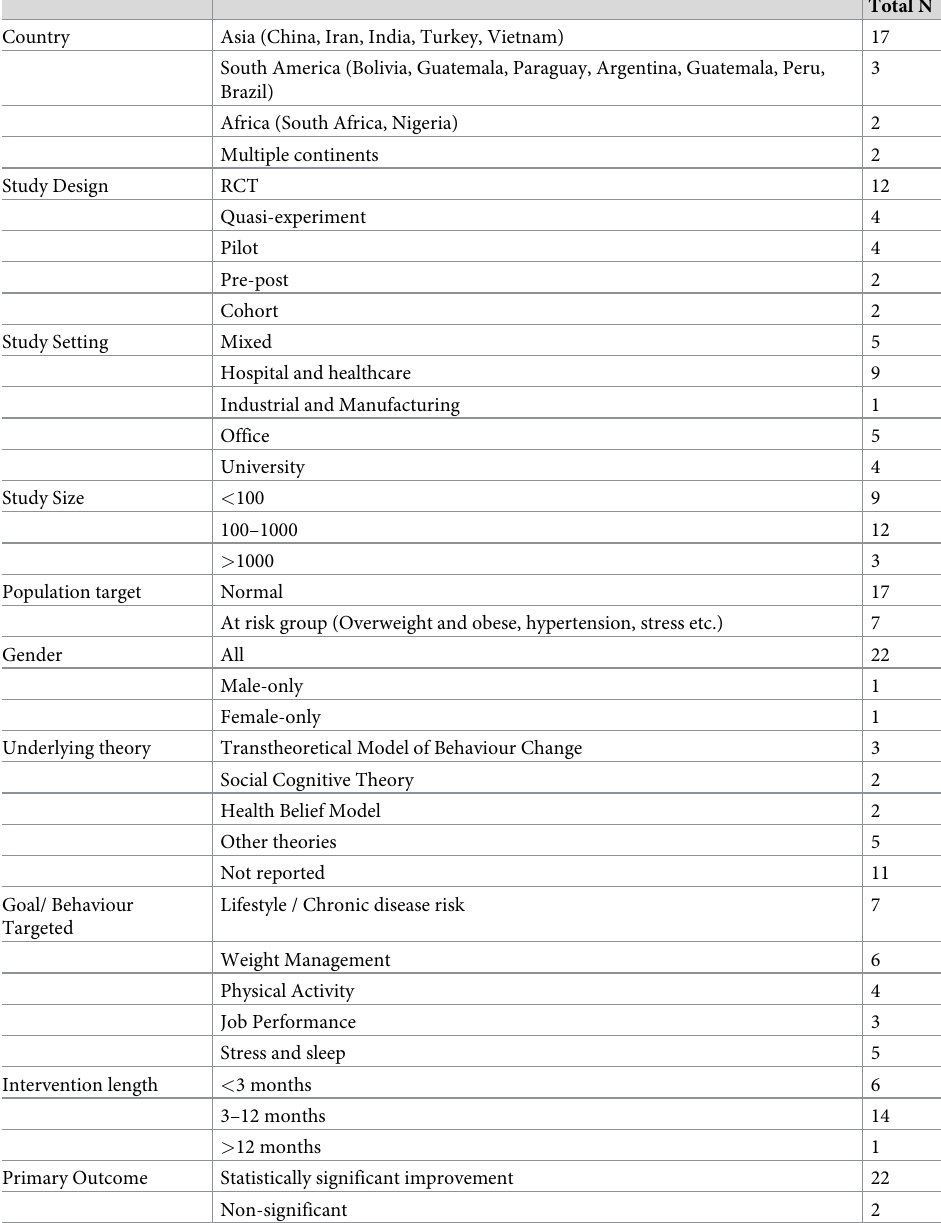
Table 2. Tabulated results of included